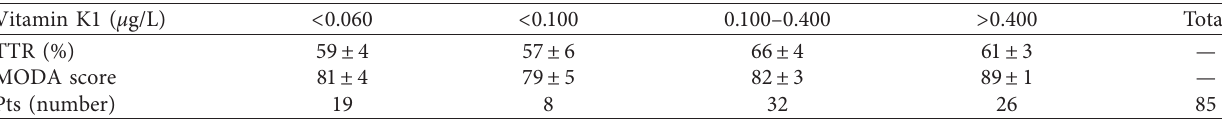
Table 2: MODA scores and percentage of time in therapeutic range (TTR%) according to the plasmatic levels of vitamin K1. For both the MODA score and the TTR%, the value and the associated error are the mean and the standard error, respectively. Vitamin K1 ( μ g/L)